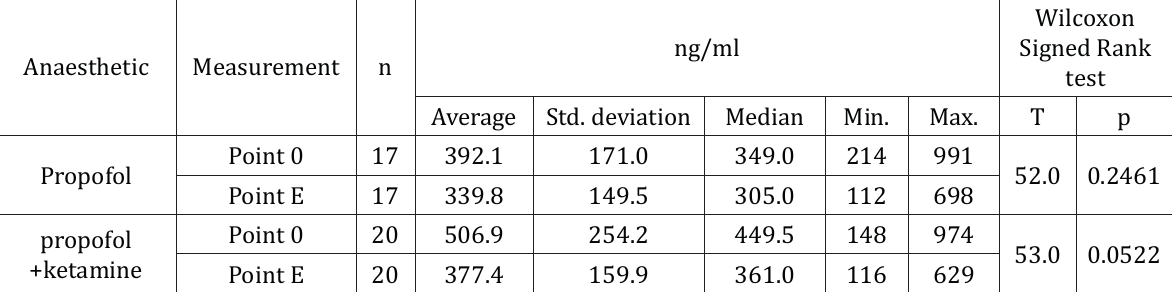
Table 5. Descriptive statistics – Concentration of MMP-9 in patients treated using different anaesthetics at two points in time and the results of a Wilcoxon Signed Rank